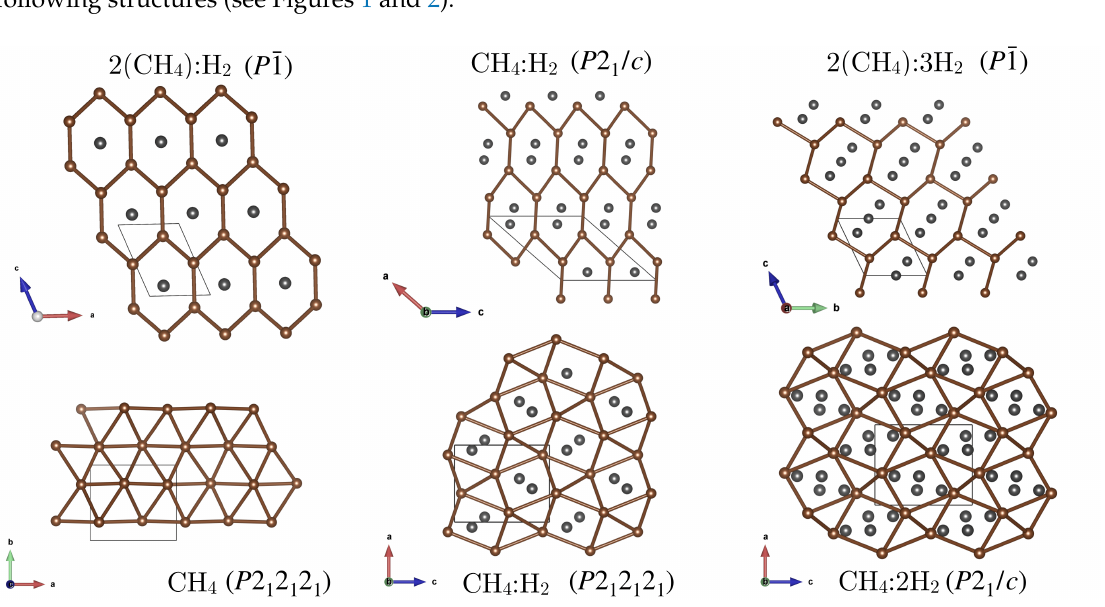
Figure 1. Illustrations of methane sublattice connectivities in van der Waals inclusion compounds. Carbon atoms are indicated in brown, H 2 molecules in dark grey; methane hydrogen atoms are omitted. The methane network is indicated by brown lines connecting carbon vertices. (CH 4 ) 2 H 2 - P ¯1, CH 4 (H 2 ) 2 - P 2 1 / c , and (CH 4 ) 2 (H 2 ) 3 - P 1 have a common methane network. Both